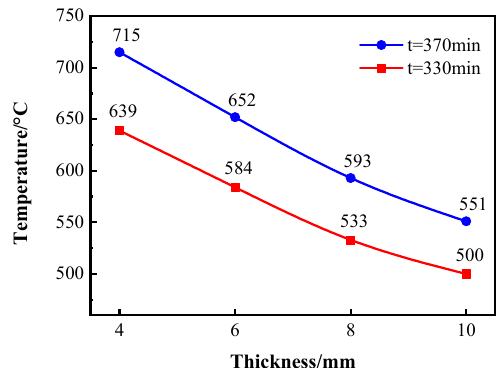
Figure 4. Induction coil temperature before and after steel-teeming stage with different coating thicknesses.